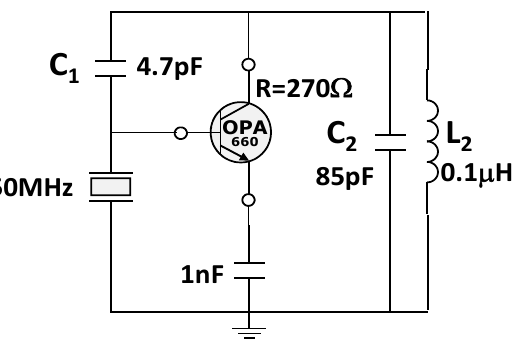
Figure 2. Schematic of the Miller oscillator